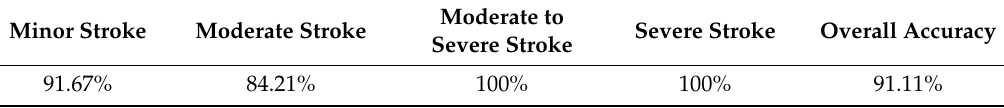
Table 10. The performance evaluation in stroke severity class classification and prediction.